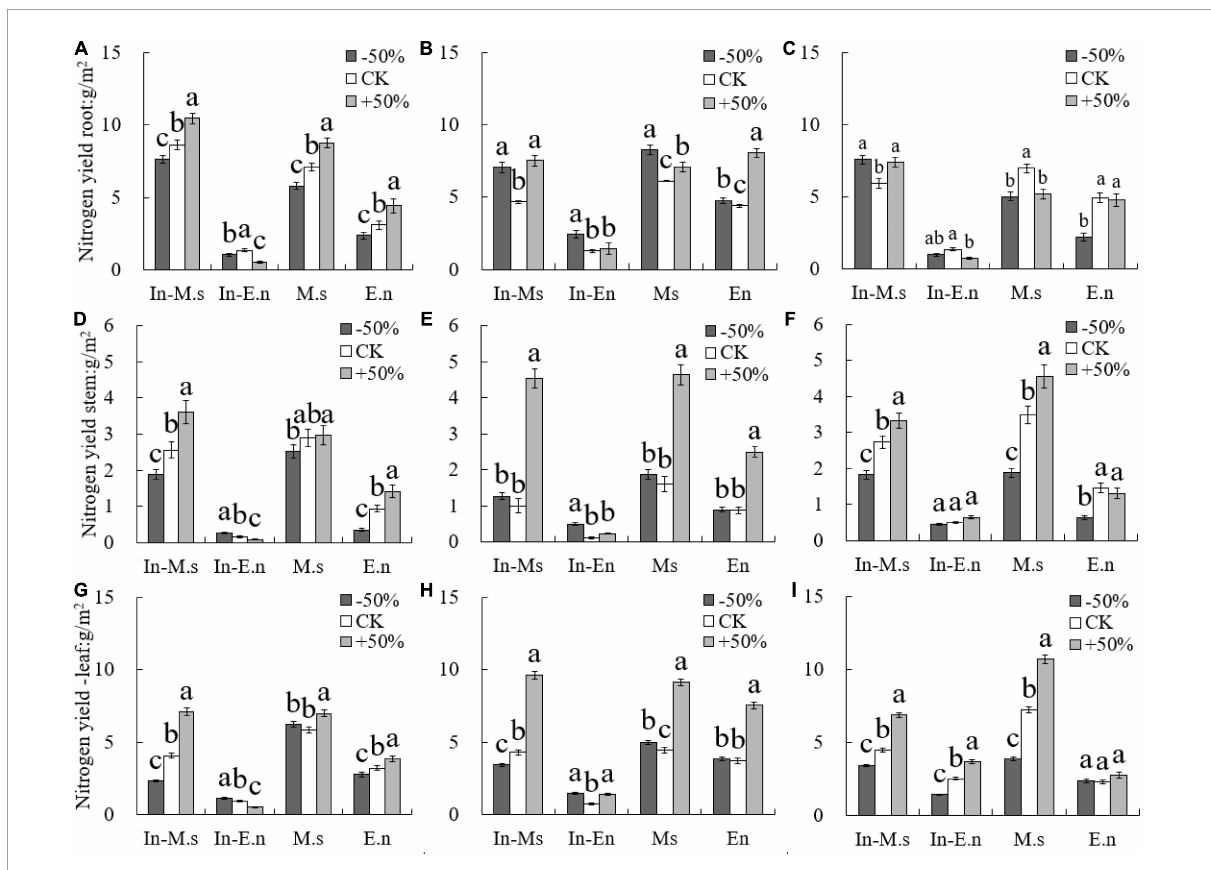
FIGURE5 Effect of water on nitrogen yield of different forages ( A,D,G : 2015; B,E,H : 2016; C,F,I : 2017). Different lowercase letters show significant differences under different water levels ( P <